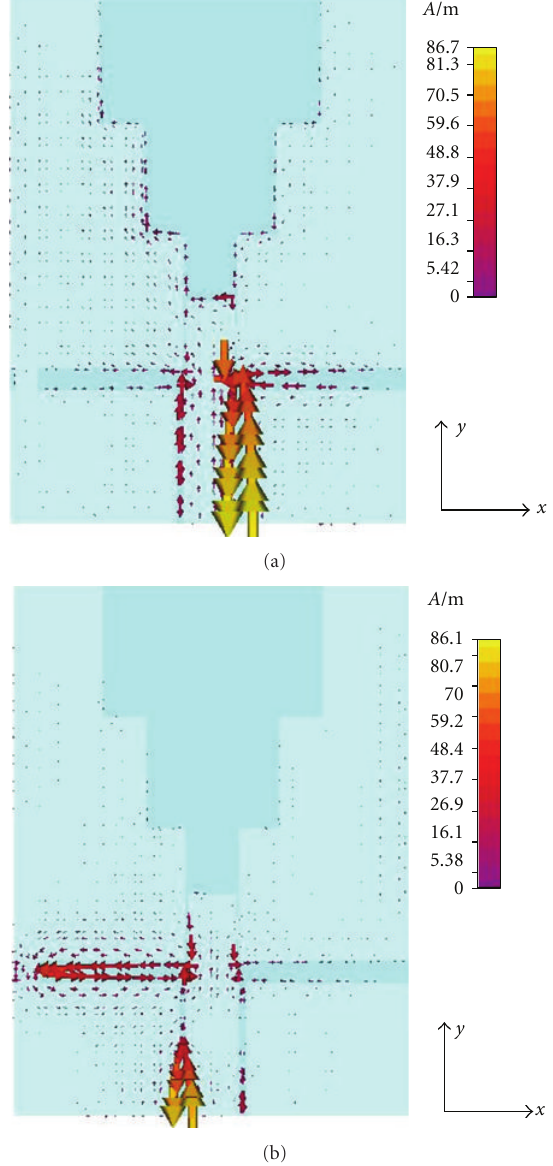
Figure 3: The current distributions of the proposed antenna (a) at 4.5GHz (b) and 5.5